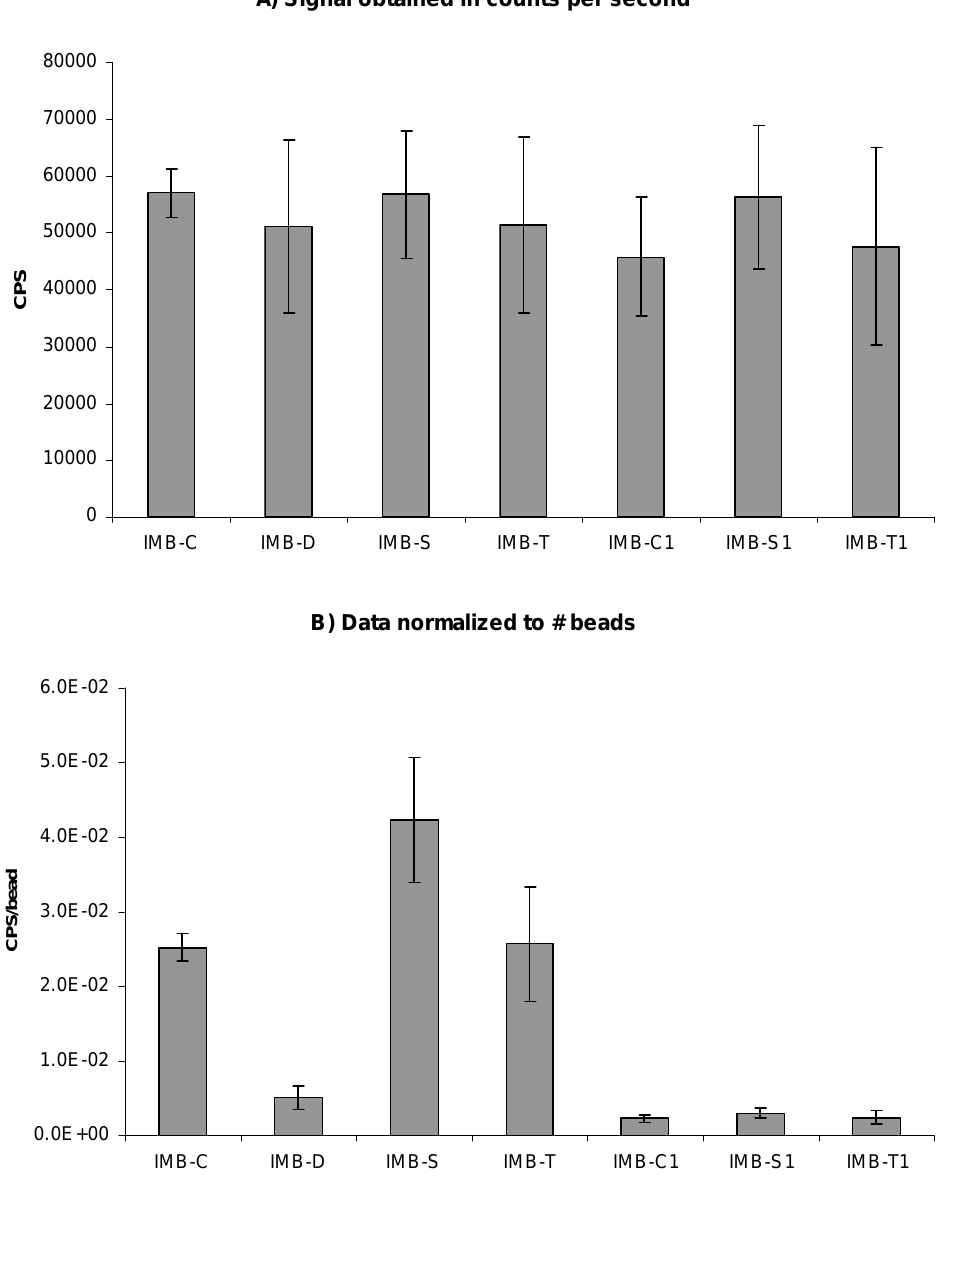
Figure 4. Capture of E. coli O157:H7 strain B1409 from ground beef. Strain B1409 was inoculated into ground beef at a concentration of 1 cfu/g, enriched for 24 h in mEC broth, and assayed with each IMB. A) shows the results obtained in counts per second, with all IMB producing a similar response ( P = 0.64). However, when the data is normalized to the number of beads used per assay (B), the results were quite different with IMB-C, IMB-S, and IMB-T giving the greater signal. The data obtained is from three independent experiments run in duplicate. The average percent error among these replicates was